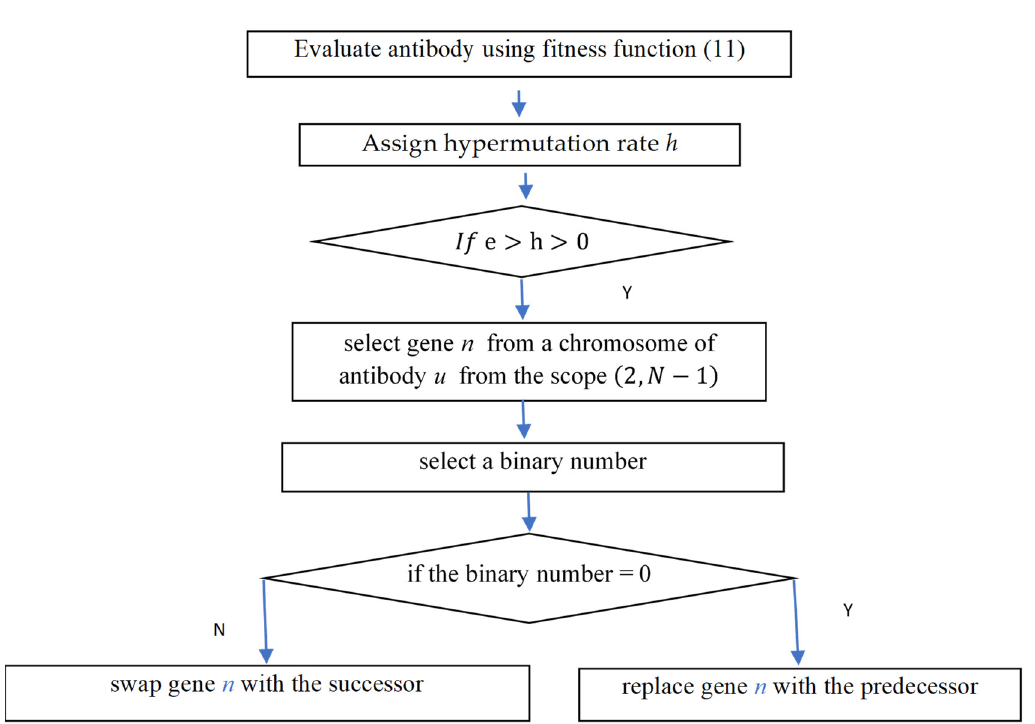
Figure 14. Block diagram of the hypermutation procedure.